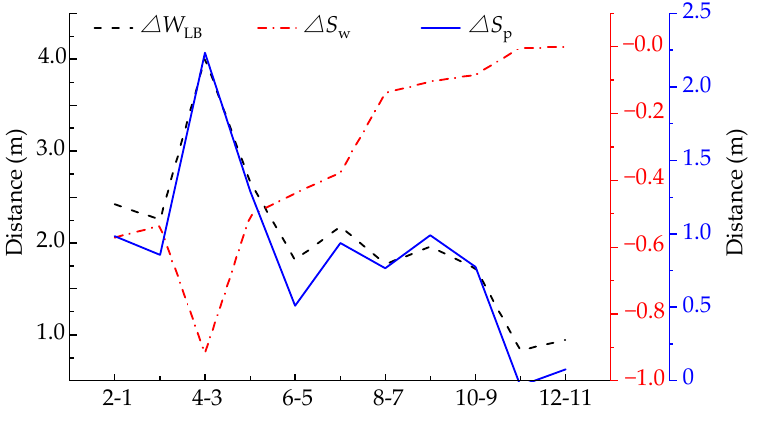
Figure 10. Increment curve.